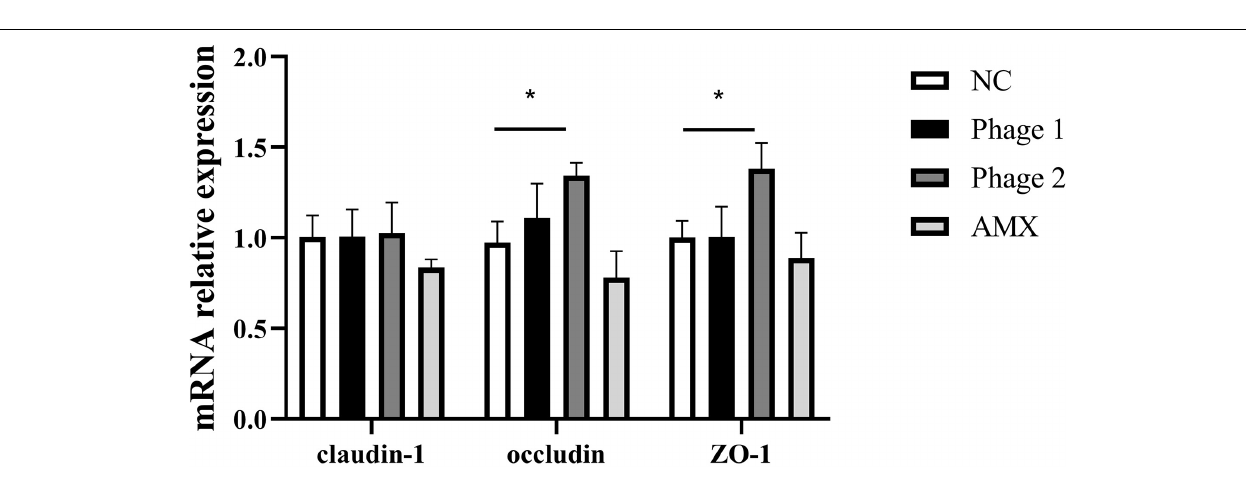
enrichment of Clostridia _UCG-014 (from order to genus) and unclassified_c__ Clostridia (from order to genus) in the NC group. Unclassified_p__ Firmicutes (from class to genus), Lactobacillales , Enterococcaceae (from family to genus), Leuconostocaceae (from family to genus), and Christensenellaceae (from family to genus) were enriched in the Phage 1 group. In